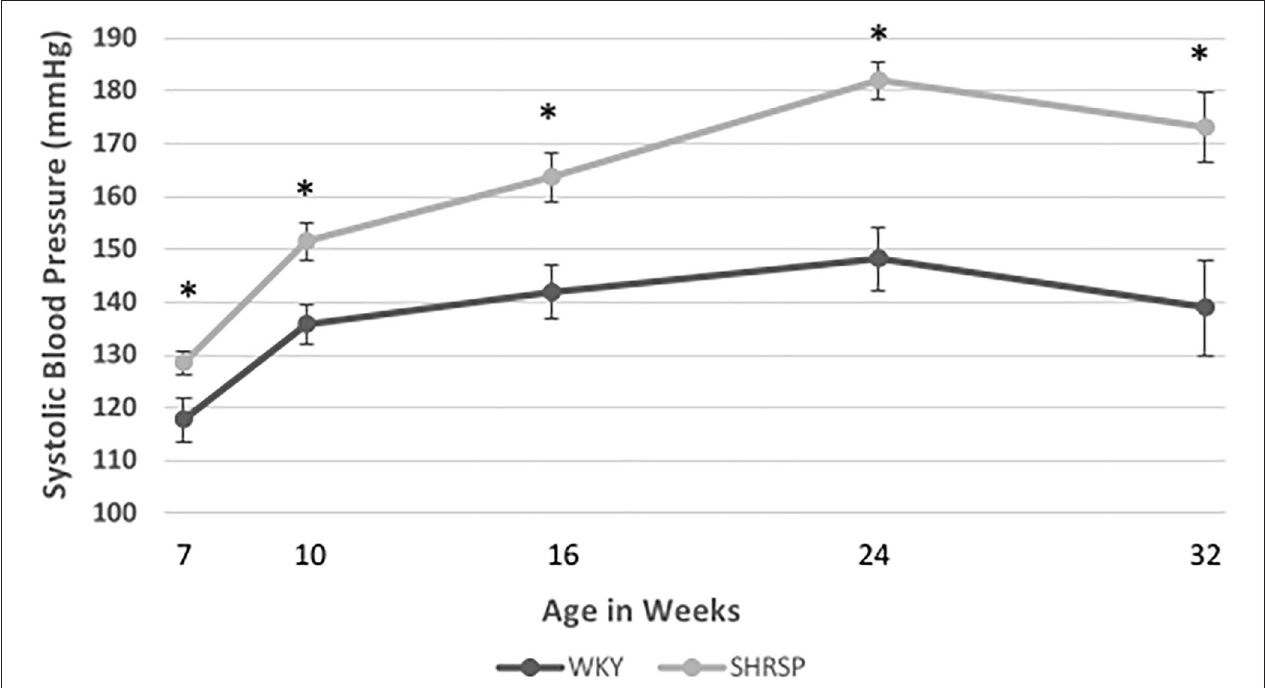
FIGURE 1 | Temporal changes of systolic blood pressure (SBP) in WKY and SHRSP mm Hg (millimeter of mercury) at 7 (21 WKY, 17 SHRSP), 10 (26 WKY, 23 SHRSP), 16 (15 WKY, 15 SHRSP), 24 (8 WKY, 5 SHRSP), and 32 (7 WKY, 5 SHRSP) weeks of age. Throughout the experiment, SHRSP had statistically significant higher SBP compared to WKY. At the beginning of the experiment, SHRSPs were still not hypertensive. Subsequently, SHRSP developed hypertension which was sustained throughout their lifespan. Data are presented as means and standard errors. WKY, Wistar Kyoto Rats; SHRSP, Spontaneously Hypertensive Stroke-Prone Rats ( * represents statistical significant difference of P <